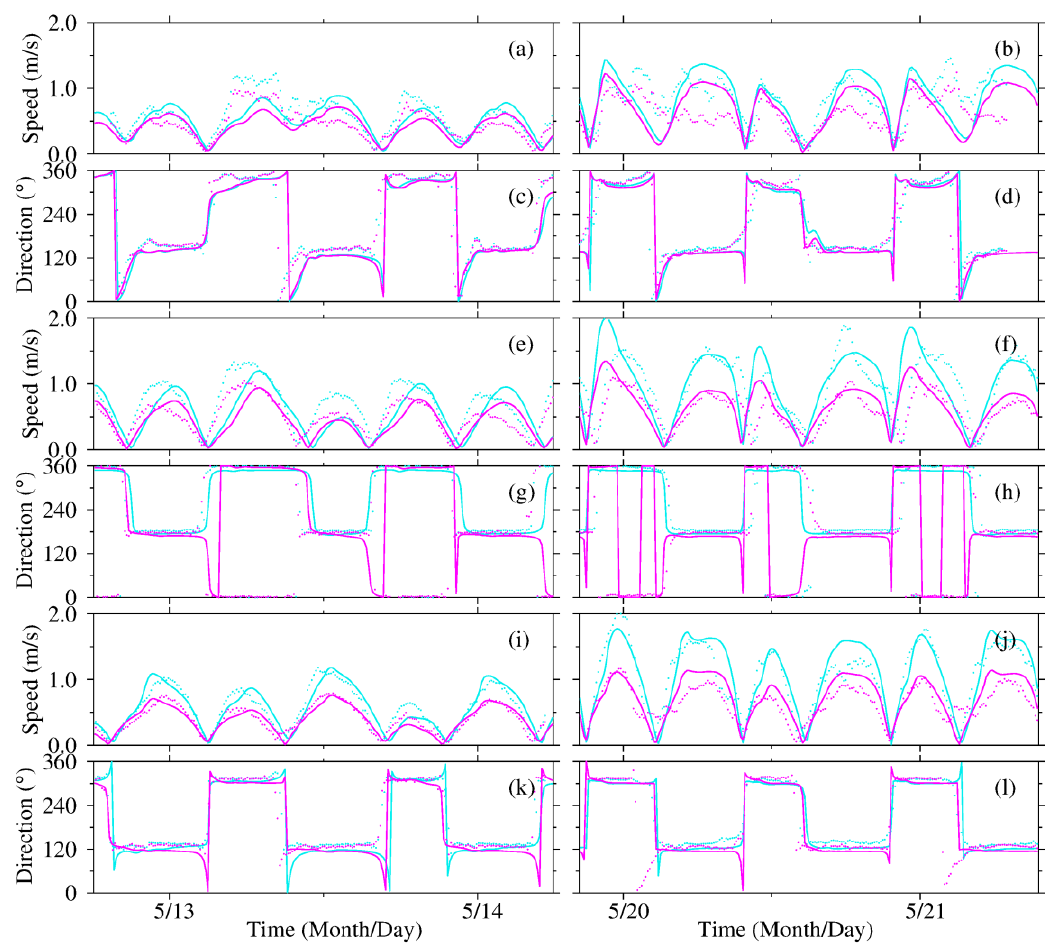
Figure 6. Comparison between the modeled (dots) and observed (lines) current velocities and current directions at measurement sites A ( a – d ), B ( e – h ) and C ( i – l ) during the neap tide (left panels) and spring tide (right panels). Blue indicates the surface layer, and violet indicates the bottom layer.